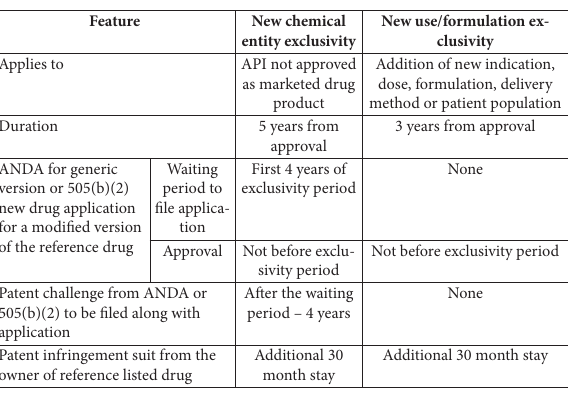
Table 2. Comparison between new chemical entity exclusivity and new use/formulation exclusivity in drugs that are being re-